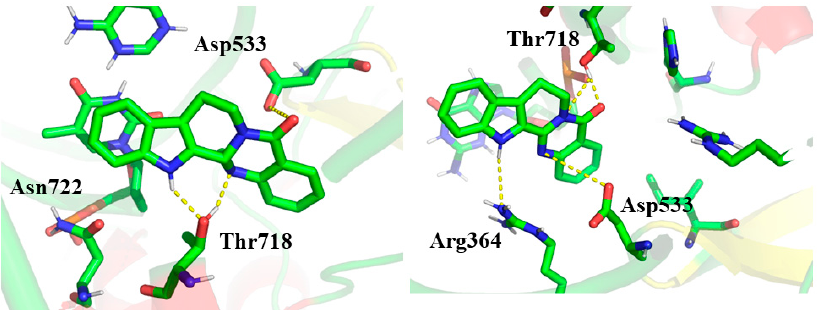
Figure 4. Binding mode of evodiamine (EVO) (left) and rutaecarpine (RUT) (right) with the TOP1– DNA complex. The ligand and relevant amino acids are represented by a stick diagram (green for carbon atom, red for oxygen atom and blue for nitrogen atom), while TOP1-DNA is depicted by a cartoon diagram. Hydrogen bond interactions are shown in yellow dotted lines.